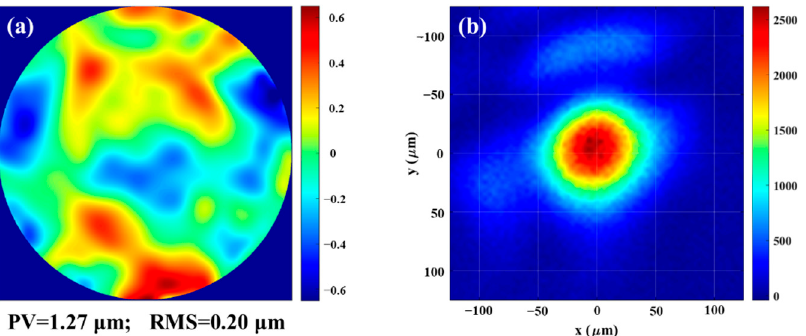
Figure 2. Measured ( a ) wavefront and ( b ) focal spot of SULF-1PW laser beamline without AOS.